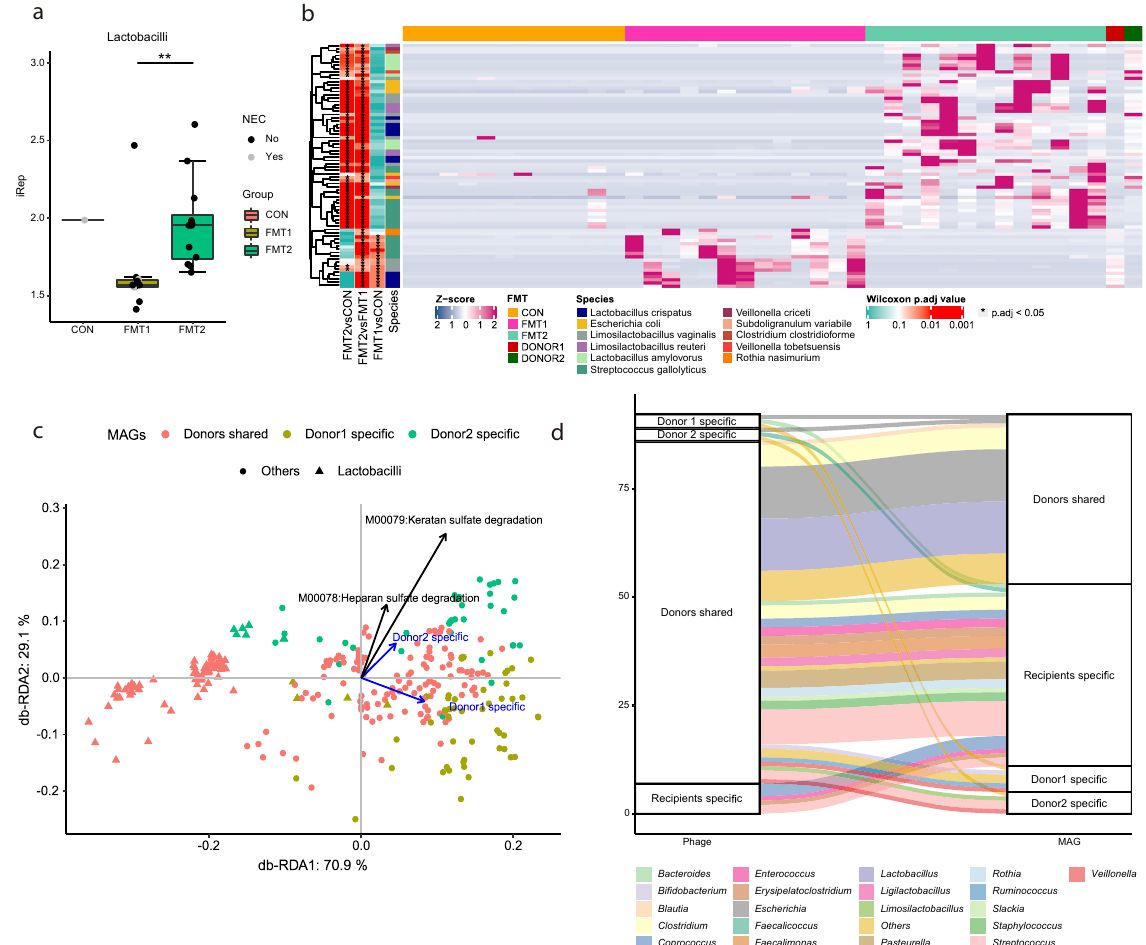
Fig. 7 Genome-resolved analysis revealed donor-speci fi c patterns in recipient piglets. The replication rate of lactobacilli genomes ( a ) and the abundance of engrafted MAGs ( b ) displayed donor-dependent differences. The functional similarity of donor-speci fi c MAGs is shown by the db-RDA triplot with the scaled loadings of the glycosaminoglycans-degradation modules ( c ). Host-virus pairs are validated with spacers, where the colors of fl ows suggest the host taxonomy ( d ). The labels of * and ** represent adjusted p < 0.05 and 0.01 (Wilcoxon rank-sum test with Benjamin-Hochberg correction). Respectively n = 13, 13, 12 for FMT1, FMT2 and CON. In boxplots, the inner fences are depicted as error bars. FMT1 rectal FMT with Donor 1, FMT2 rectal FMT with Donor 2, CON rectal FMT with sterile saline as